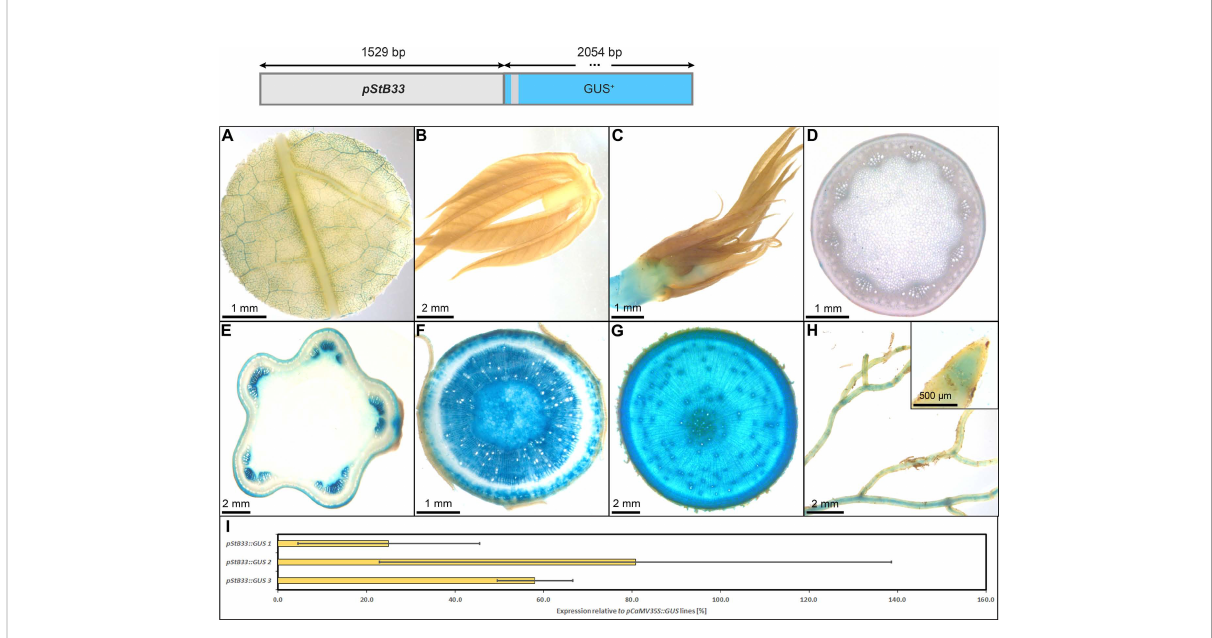
FIGURE 10 Representative GUS staining pattern of at least four pStB33 promoter-reporter lines. (A) Source leaf, (B) Sink leaf, (C) Emerging leaves, (D) Petiole cross-section, (E) Upper stem cross-section, (F) Lower stem cross-section, (G) Storage root cross-section, (H) Fibrous roots (Inlay = Root tip), (I) GUS expression levels of three pStB33::GUS lines relative to three pCaMV35S::GUS lines in %. Bars represent mean values with standard deviation